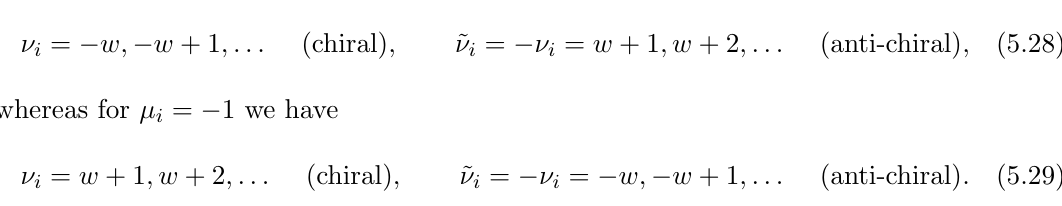
while (cid:0) (cid:23) . Notice that the (cid:0) ~ (cid:23)